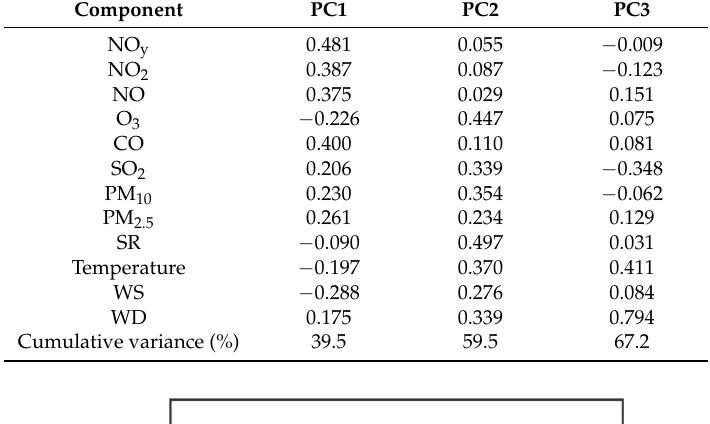
Table 5. Results of the PCA performed using observations for air pollutants and meteorological data recorded at the OBI site from September 2012 to August 2013.